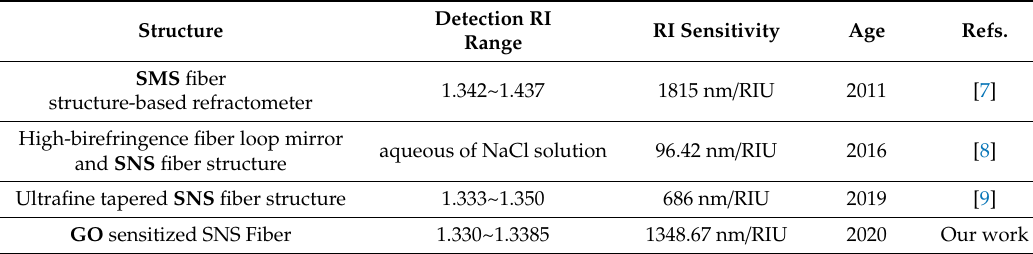
Table 3. Comparison of refractive index sensitivity of SMS structure from the literature.